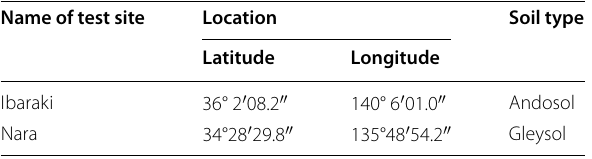
Table 2 Characteristics of the two test